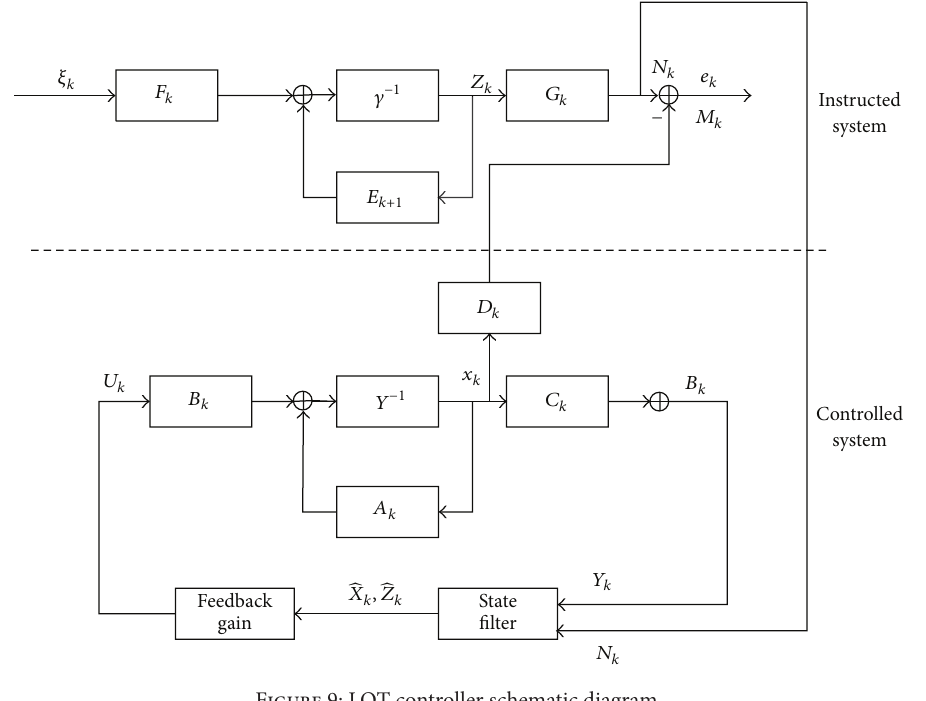
Figure 9: LQT controller schematic